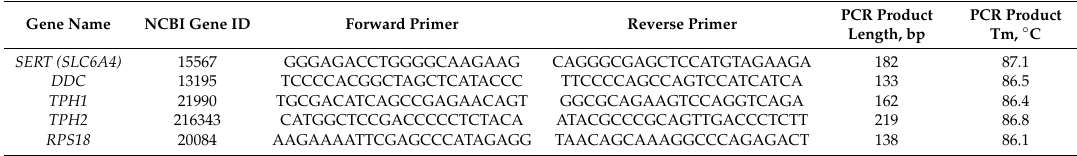
Table 1. Oligonucleotide primers used for quantitative real-time PCR